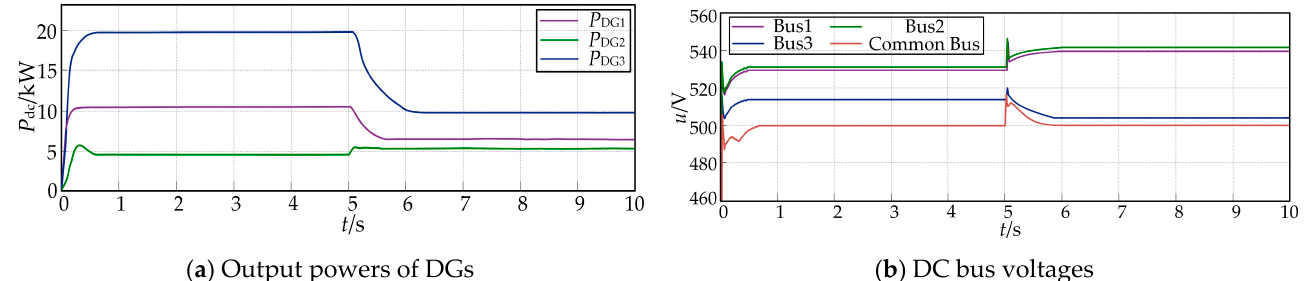
Figure 18. Simulation results of example 2 under the proposed control strategy in [8].